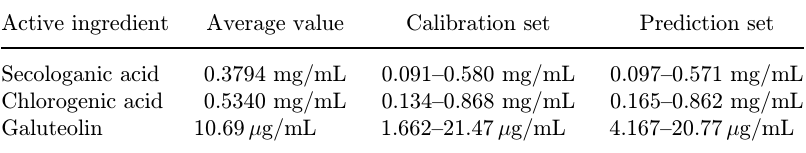
Table 3. Statistics of active ingredient content in calibration and prediction